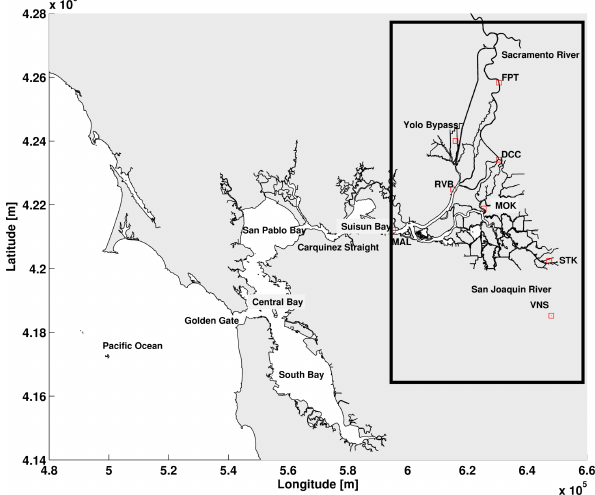
Figure 1. Location of the San Francisco Bay–Delta. The black rect- angle highlights the Delta, and the red squares indicate measure- ment